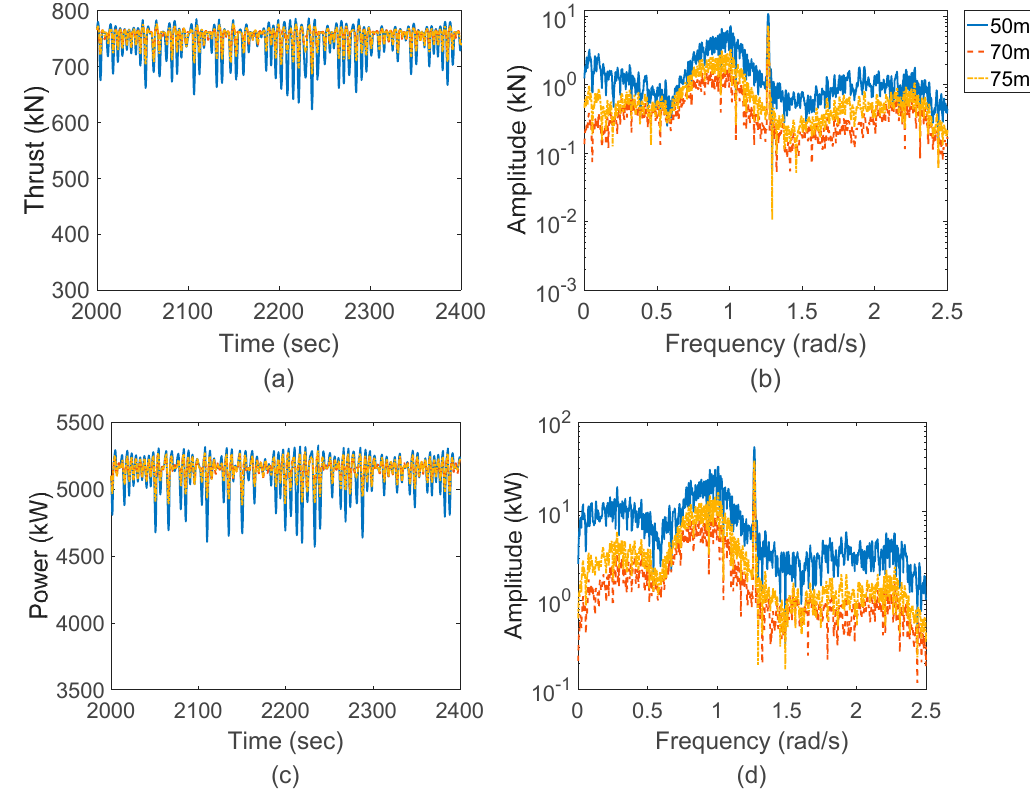
Figure 8. Aerodynamic performance of the rotor. ( a ) Time histories of thrust on the rotor ( b ) Response spectra of thrust on the rotor ( c ) Time histories of output power ( d ) Response spectra of output